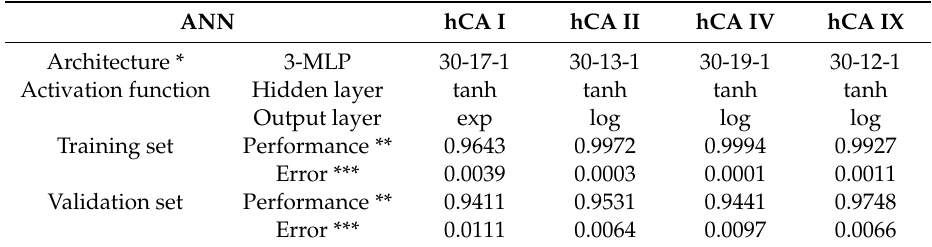
Table 2. Summarized information about computed three-layer-perceptron architectures used for prediction of inhibitory data against selected human carboanhydrases (hCAs). ANN hCA I hCA II hCA IV hCA IX Architecture *